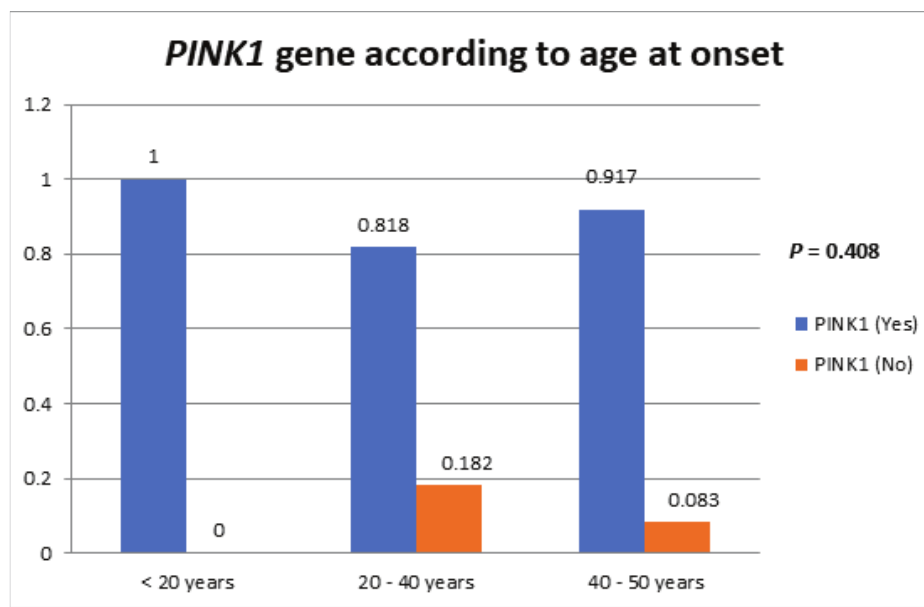
Figure 5: PINK1 gene expression according to the age at onset.